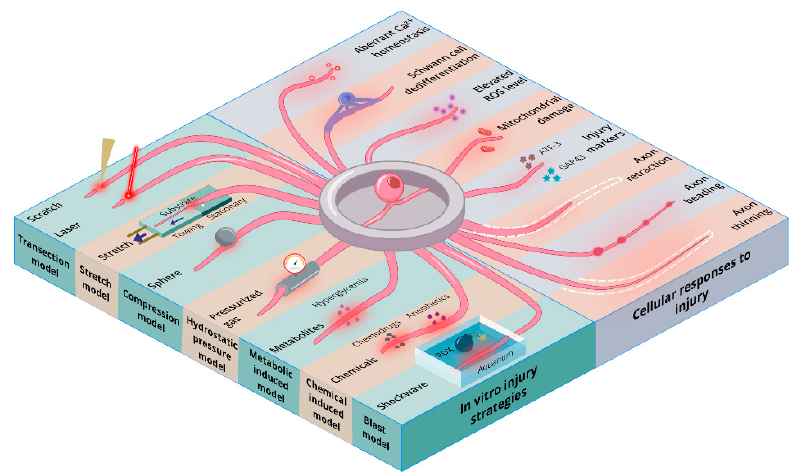
Figure 1. Schematic overview depicting various in vitro peripheral nerve injury models and peripheral cellular responses to injuries.